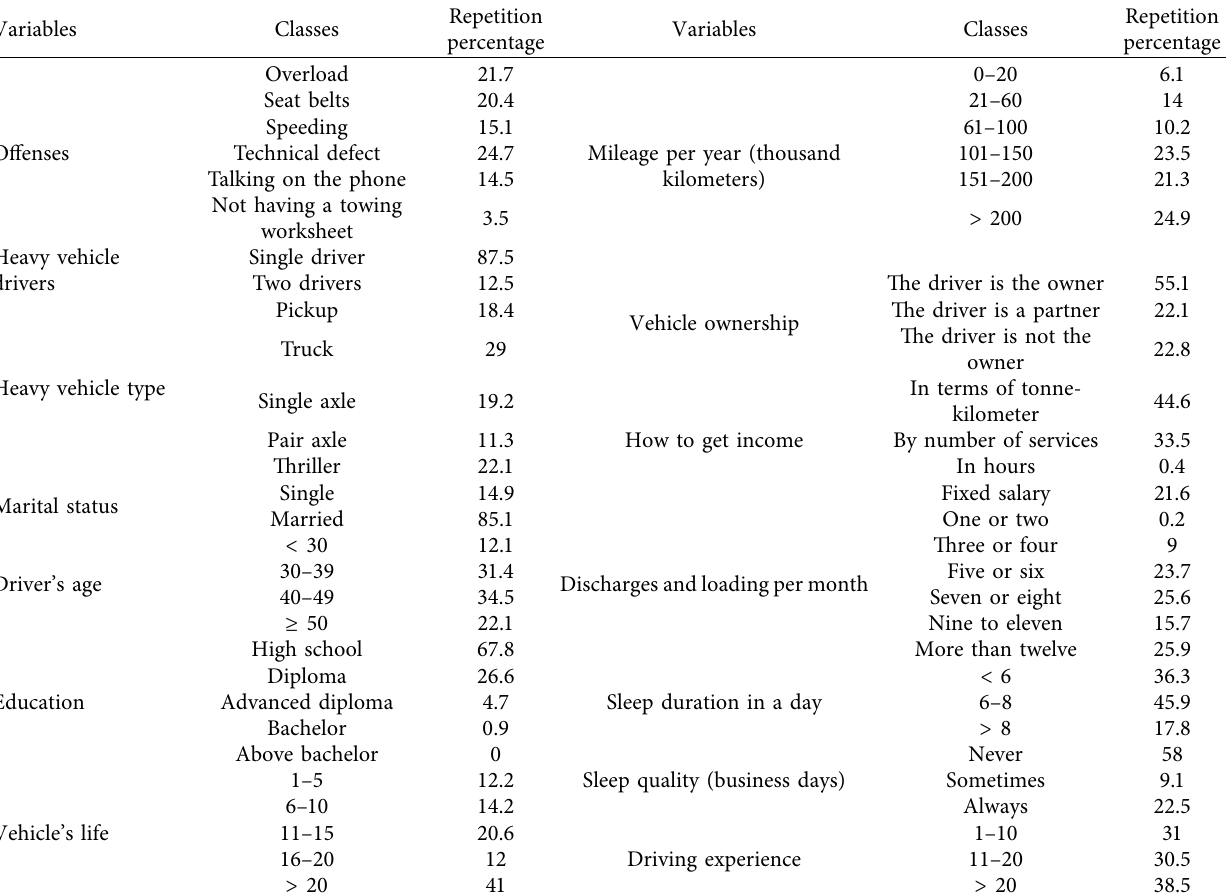
Table 2: Evaluated variables with the frequency of each